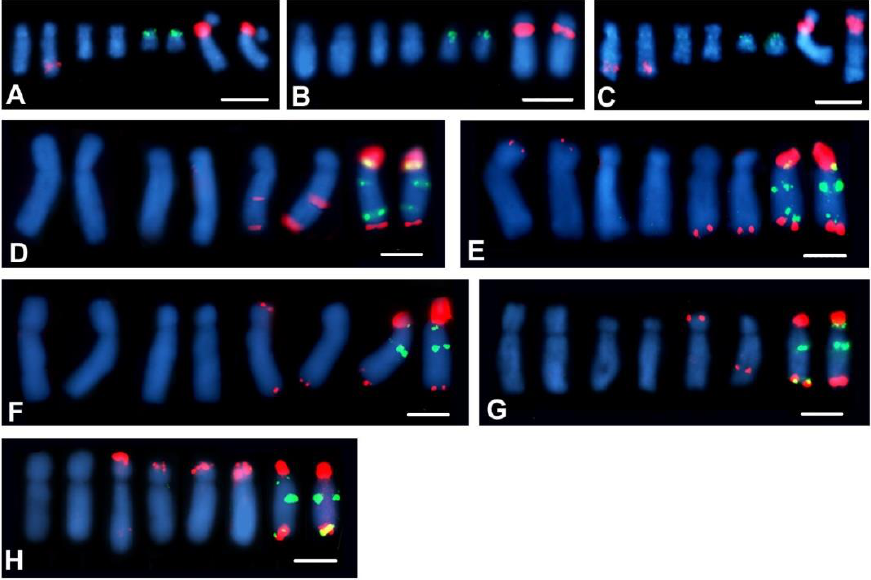
Figure 6. Karyotypes of Crepis species showing intraspecific polymorphisms of the rDNA loci num- ber and localisation: ( A ) — C. setosa 1, ( B ) — C. setosa 2, ( C ) — C. setosa 2, ( D ) — C. conyzifolia 1, ( E ) — C. number and localisation: ( A ) C. setosa 1, ( B ) C. setosa 2, ( C ) C. setosa 2, ( D ) C. conyzifolia 1, conyzifolia 2, ( F ) — C. conyzifolia subsp. Dshimilensis , ( G ) — C. pannonica 1 and ( H ) — C. pannonica 2. Scale ( E ) C. conyzifolia 2, ( F ) C. conyzifolia subsp. Dshimilensis , ( G ) C. pannonica 1 and ( H ) C. pannonica bar = 5 µm 2. Scale bar = 5 µ